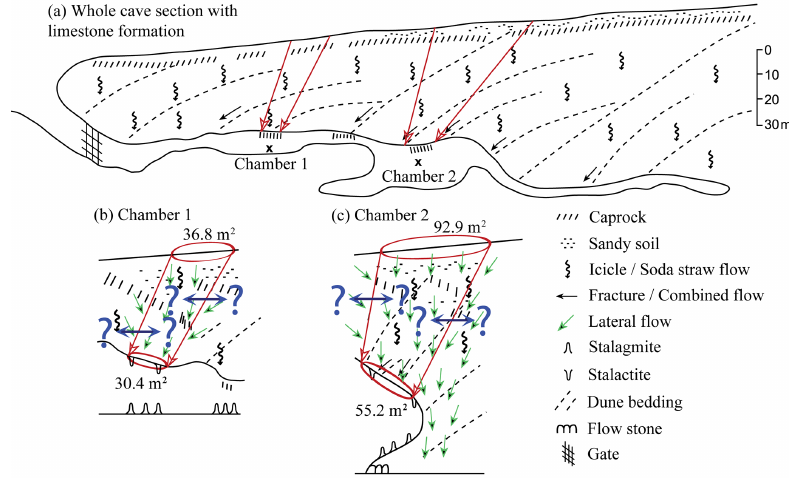
Figure 10. Representation of groundwater flow for the Tamala limestone formation in Golgotha Cave. (a) shows a vertical section of the entire cave with possible groundwater flows. (b) and (c) illustrate close views of chambers 1 and 2 labelling areas of ground surface infiltration and drip discharge from cave ceilings (in red circle). The “?” and arrows pointing to the left and right in (b) and (c) show that we cannot be sure of the precise flow route, although we are able to quantify the flow